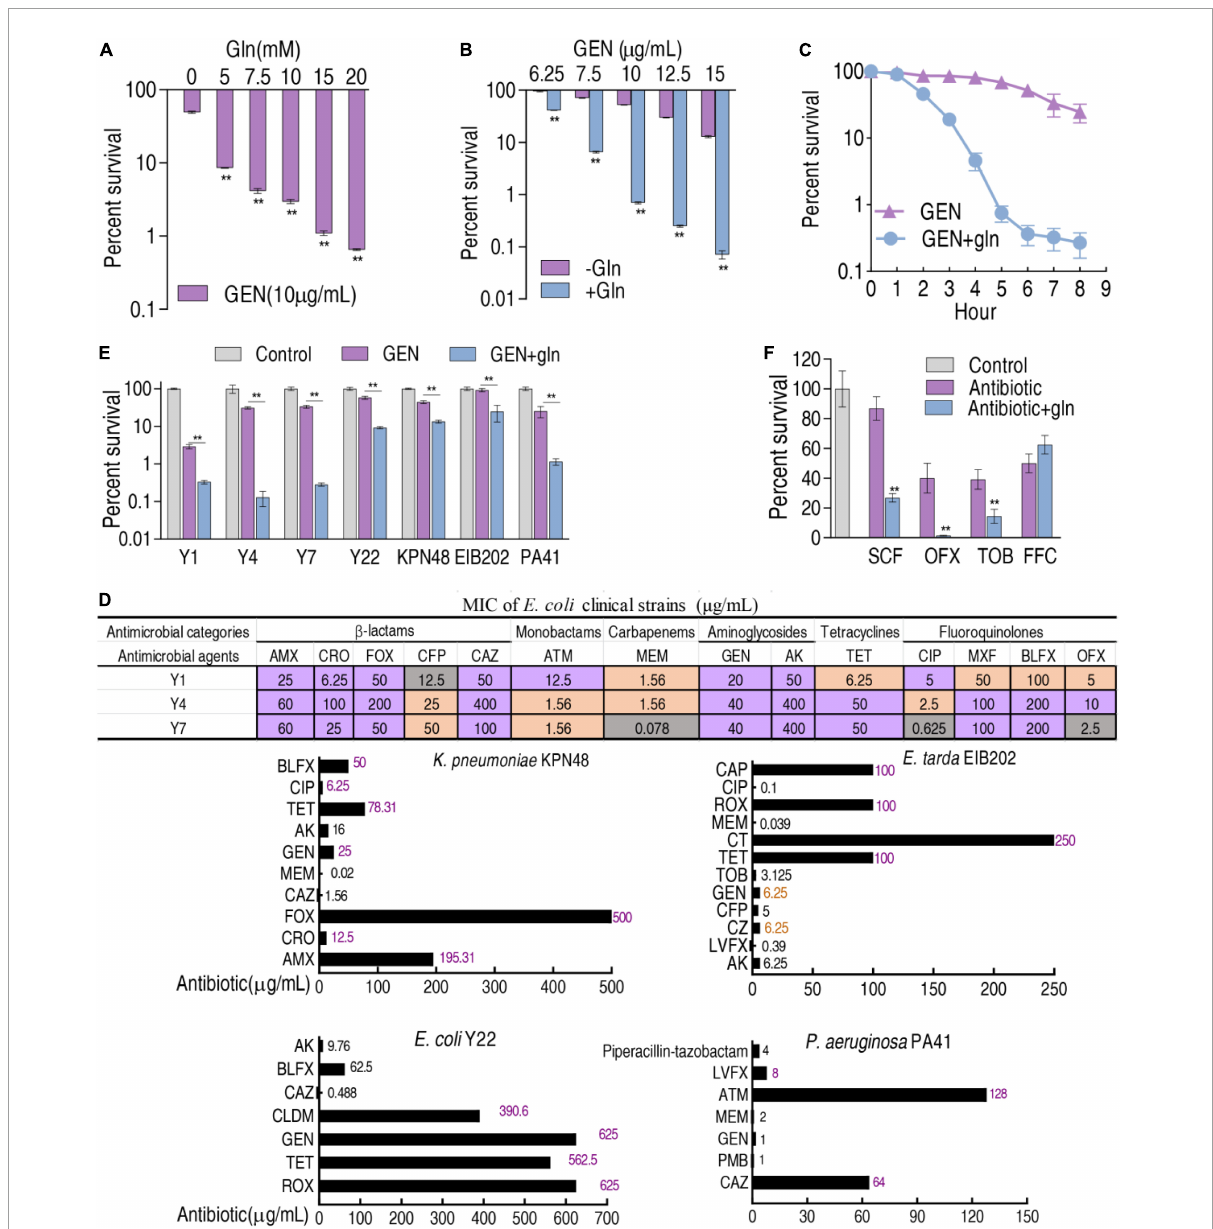
FIGURE6 Glutamine promotes gentamicin-mediated killing. (A) Percent survival of K12-R GEN in the presence of the indicated concentration of glutamine and 10 µ g gentamicin. (B) Percent survival of K12-R GEN in the presence of the indicated concentration of gentamicin and with or without 20 mM glutamine. (C) Percent survival of K12-R GEN in the indicated incubation time plus 20 mM glutamine and 10 µ g gentamicin. The concentration of K12-R GEN in (A–C) was 5 × 10 8 CFU/ml. (D) MIC measurement of clinically isolated bacterial strains in four to six kinds of antibiotics commonly used in clinical practice. Purple indicates resistant; orange indicates intermediate; dark gray indicates susceptible. For AMX, CRO, FOX, CFP, CAZ, MEM, GEN, CIP, TET, CLDM, PMB, LVFX, CZ, CT, TOB, CAP, and ROX, the standard was according to reference (CLSI, 2012). For ATM, OFX, and AK, the standard was according to reference (Kahlmeter et al., 2006). For MXF and BLFX, susceptible, intermediate, and resistant E. coli were defined as MIC ≤ 0.025, MIC = 0.05, and MIC ≥ 0.1 and MIC ≤ 0.05, MIC = 0.1, and MIC ≥ 0.2, respectively. (E) Percent survival of clinically isolated strains in the presence or absence of gentamicin (Y1 at 2 µ g/ml; Y4, Y7 at 2.5 µ g/ml; Y22 at 100 µ g/ml; K. pneumoniae KPN48 (2 µ g/ml); E. tarda EIB202 (2 µ g/ml); P. aeruginosa PA41 (1 µ g/ml), or in the presence of both gentamicin and 20 mM glutamine. (F) Percent survival of K12-R GEN in the indicated antibiotics (SCF, 10 µ g/ml; OFX, 1.5 µ g/ml; TOB, 2.5 µ g/ml; FFC, 40 µ g/ml) with and without 20 mM glutamine. The concentration of clinically isolated strains in (E) and K12-R GEN in (F) was 1 × 10 6 CFU/ml. Amoxicillin (AMX), Ceftriaxone (CRO), Cefoxitin (FOX), Cefoperazone (CFP), Cefoperazone-sulbactam (SCF), Ceftazidime (CAZ), Aztreonam (ATM), Meropenem (MEM), Gentamicin (GEN), Amikacin (AK), Ciprofloxacin (CIP), Moxifloxacin (MXF), Balofloxacin (BLFX), Ofloxacin (OFX), Tetracycline (TET), Clindamycin (CLDM), Polymyxin B (PMB), Levofloxacin (LVFX), Cefazolin (CZ), Colistin (CT), Tobramycin (TOB), Chloramphenicol (CAP), Roxithromycin (ROX), Florfenicol (FFC). Results are displayed as mean ± SEM and three biological repeats are performed. Significant differences are identified. ** p <